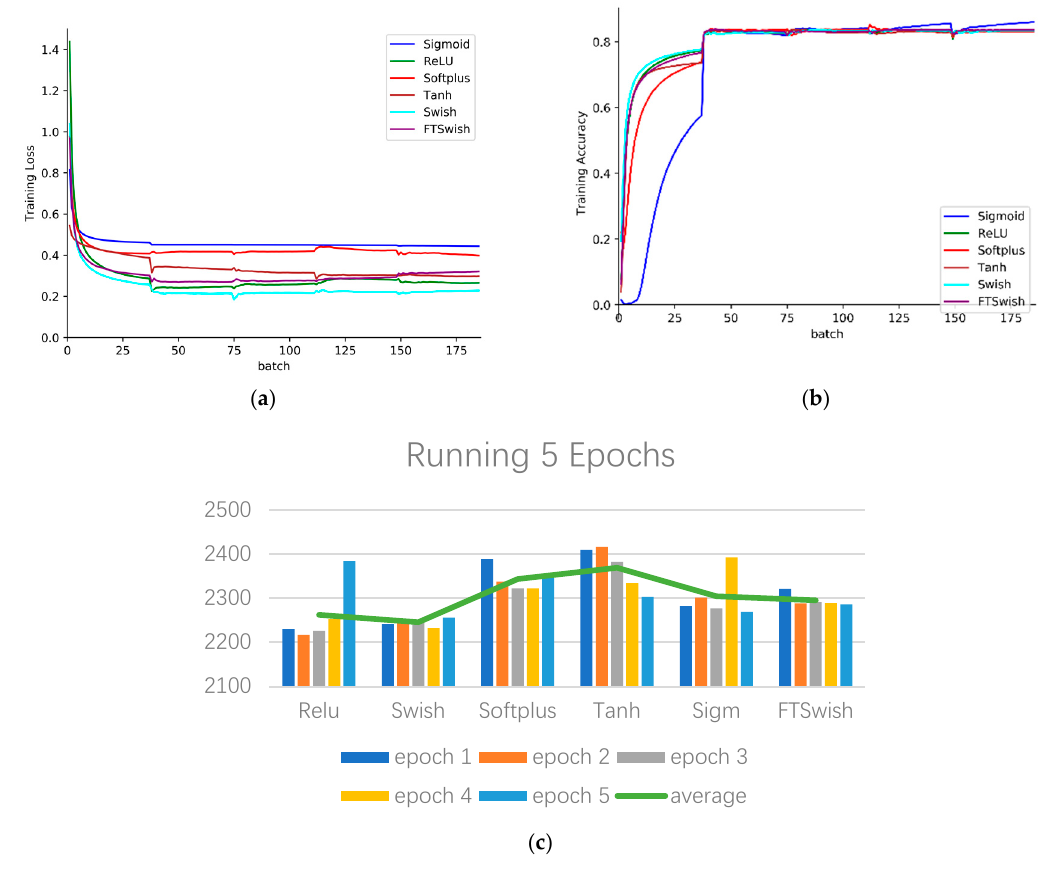
Figure 8. Comparisons of different activation functions (AFs). ( a ) Training loss; ( b ) Training accuracy; ( c ) Training time (in seconds) consuming for five epochs.